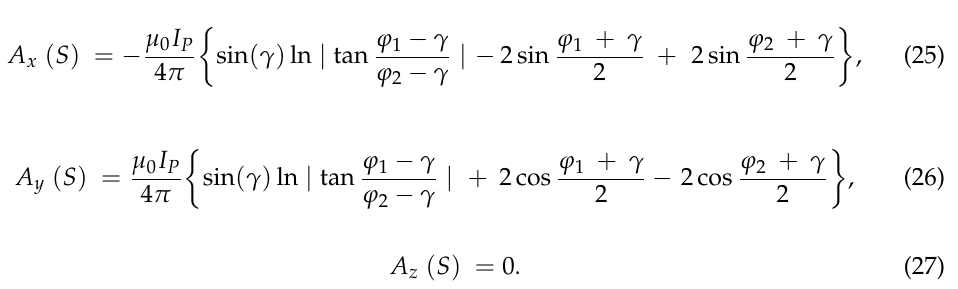
Figure 2. Point S lies between 𝜑 (cid:2869) 𝑎𝑛𝑑 𝜑 (cid:2870) where 𝑥 (cid:3020)(cid:2870) + 𝑦 (cid:3020)(cid:2870) = 𝑅 (cid:3017)(cid:2870) .